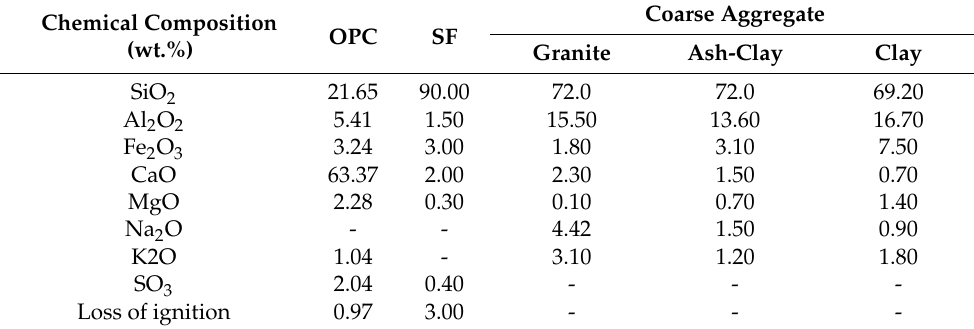
Table 1. Chemical properties of cement, silica fume and coarse aggregate.